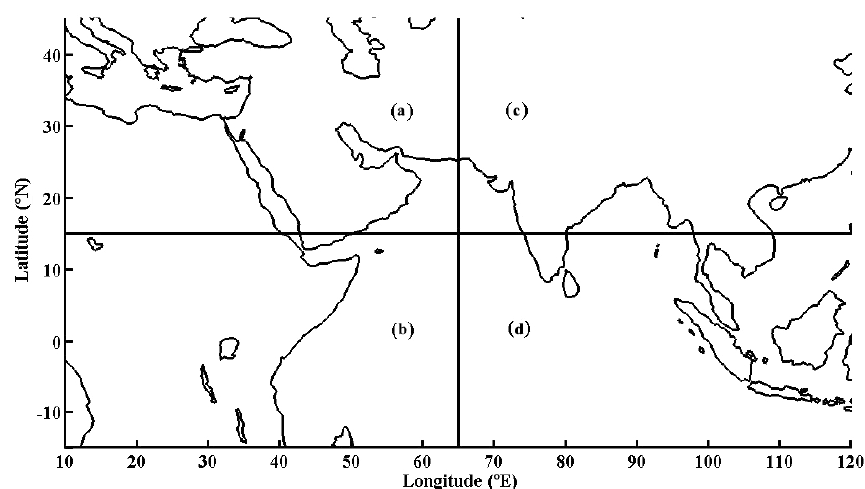
Figure 4. Regions representing the various aerosol sources for a point over the Arabian Sea. (a) the Arabian Peninsula and northern Africa, (b) central Africa, (c) the Indian sub-continent and (d) the Indian Ocean and Southeast Asia.